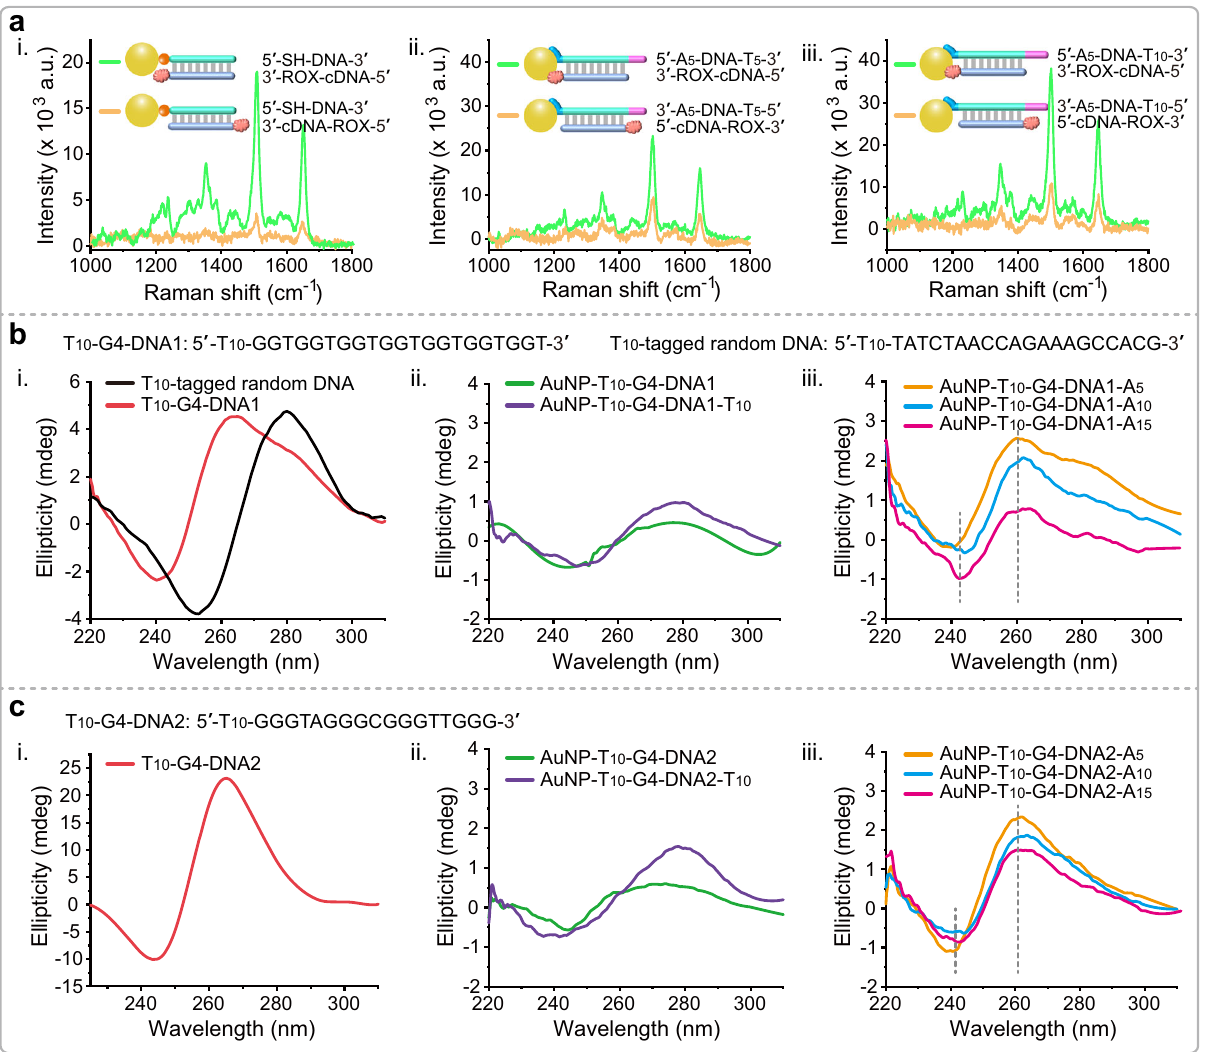
Fig. 3 Spectroscopic observation of poly (T) tag orientation in the SNA structure. a (i) SERS experiments showing the Raman signal variation when cDNAs labeled with ROX at 5 ′ - and 3 ′ -terminal hybridized with the SH-DNA-AuNP conjugates, respectively. (ii) SERS experiments showing the Raman signals variation when cDNA labeled with ROX at 3 ′ -terminal hybridized with the A 5 -DNA-T 5 and T 5 -DNA-A 5 conjugated AuNP probes, respectively. (iii) SERS experiments showing the Raman signal variation when cDNA labeled with ROX at 3 ′ -terminal hybridized with the A 5 -DNA-T 10 and T 10 -DNA-A 5 conjugated AuNP probes, respectively. For all SERS experiments, 30 nm diameter AuNPs are used. a.u. arbitrary units. b (i) CD spectra of the T 10 -tagged G4-DNA1 sequence and T 10 -tagged random DNA sequence. G4-DNA1 sequence has two characteristic peaks at around 240 and 260 nm. Random DNA sequence has two characteristic peaks at around 250 and 280 nm. (ii) CD spectra of AuNP-T 10 -G4-DNA1 and AuNP-T 10 -G4-DNA1-T 10 conjugates. (iii) CD spectra of AuNP-T 10 -G4-DNA1-A 5 , AuNP-T 10 -G4-DNA1-A 10 , and AuNP-T 10 -G4-DNA1-A 15 conjugates. c (i) CD spectra T 10 -tagged G4-DNA2 sequence. (ii) CD spectra of AuNP-T 10 -G4-DNA2 and AuNP-T 10 -G4-DNA2-T 10 conjugates. (iii) CD spectra of AuNP-T 10 -G4-DNA2-A 5 , AuNP-T 10 -G4-DNA2-A 10 , and AuNP-T 10 -G4-DNA2-A 15 conjugates. mdeg